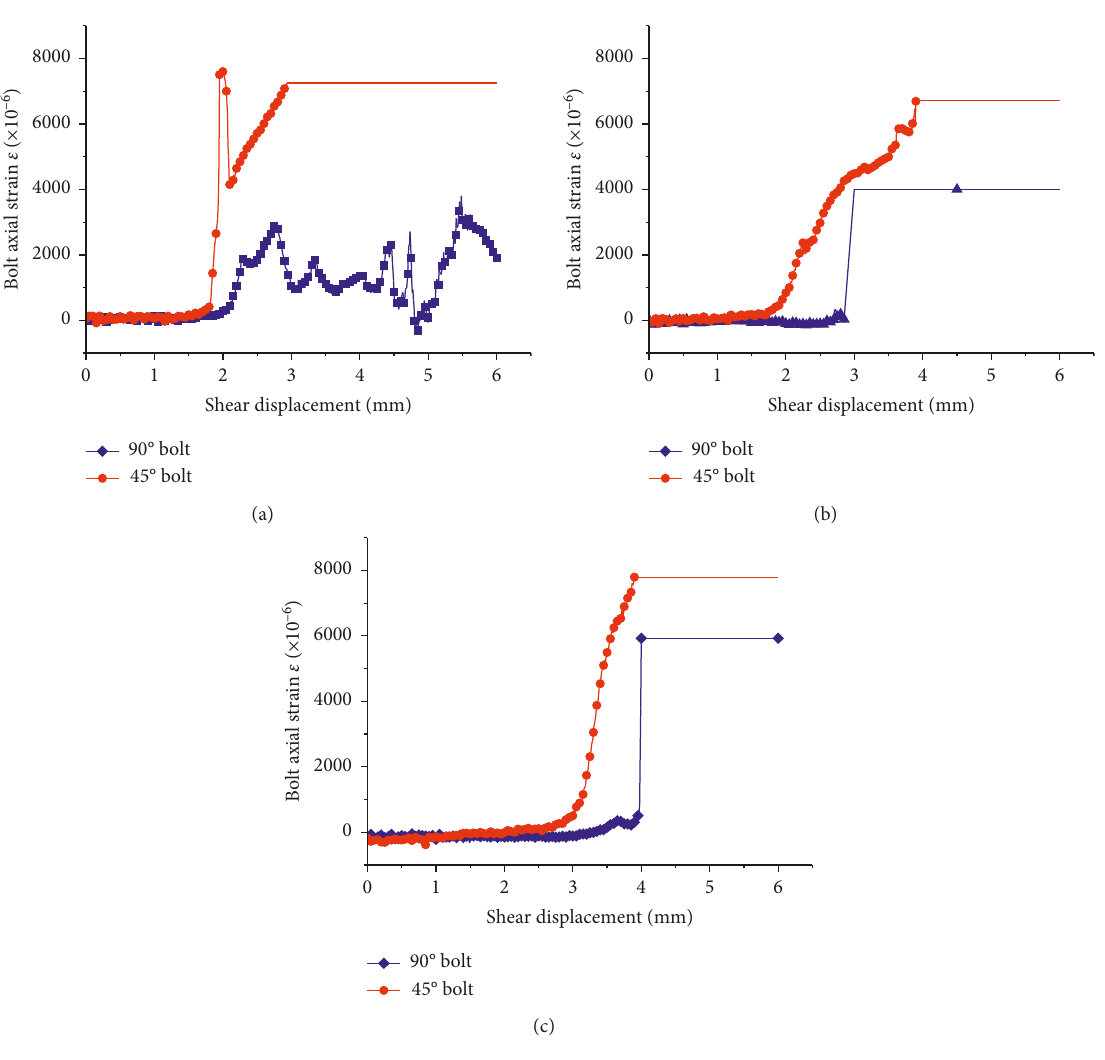
Figure 9: Strain-shear displacement curve of the bolt with a different inclination. Normal load of (a) 0.45MPa, (b) 1.33MPa, and (c) 2.22MPa.